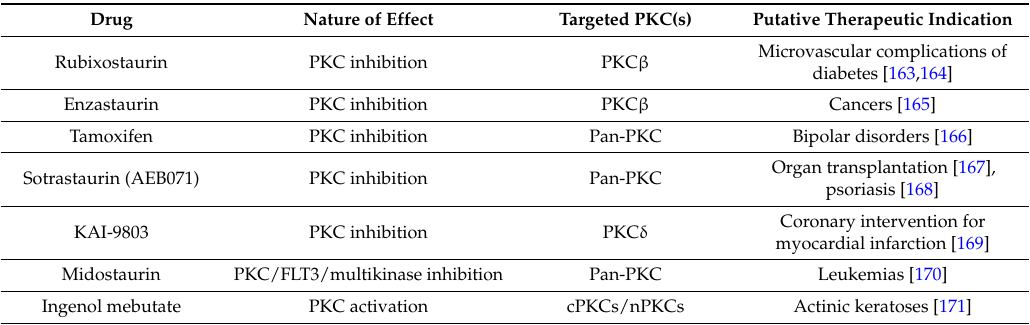
Table 4. Examples of new molecular entities targeting protein kinases C (PKCs). FLT3: Fms-like tyrosine kinase 3; cPKCs: classical/conventional PKCs; nPKCs: novel